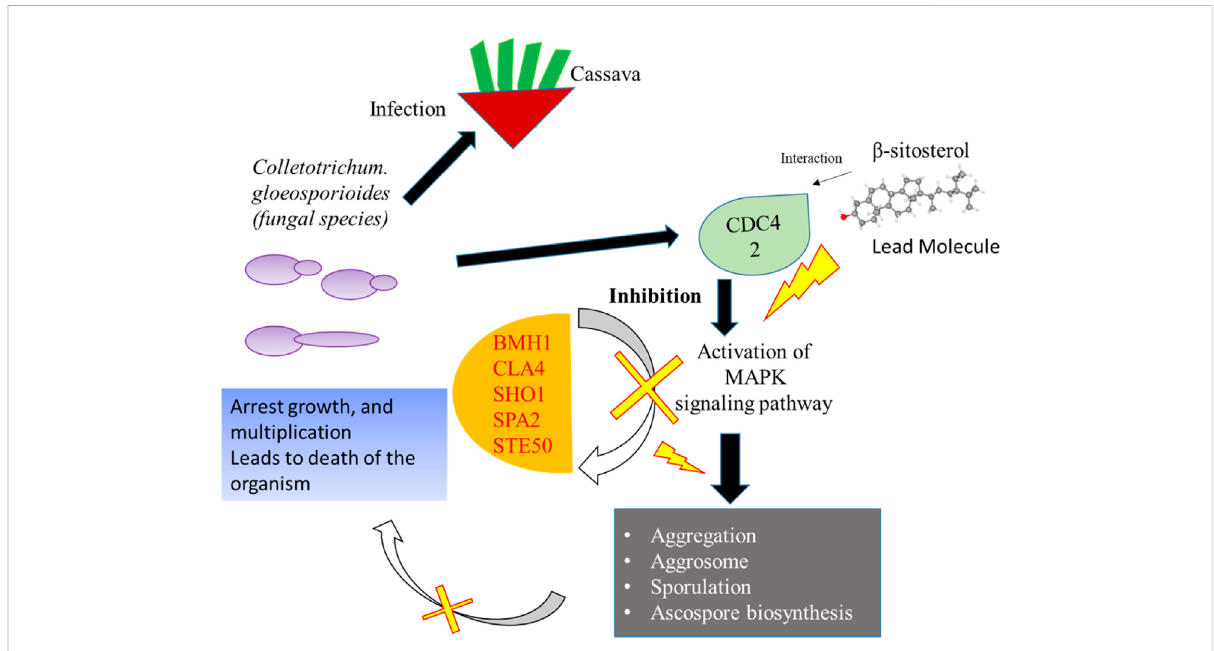
FIGURE 7 Details of the overall mechanism representing CDC42 from C. gloeosporioides involved infection and inhibition of the signaling pathway using lead